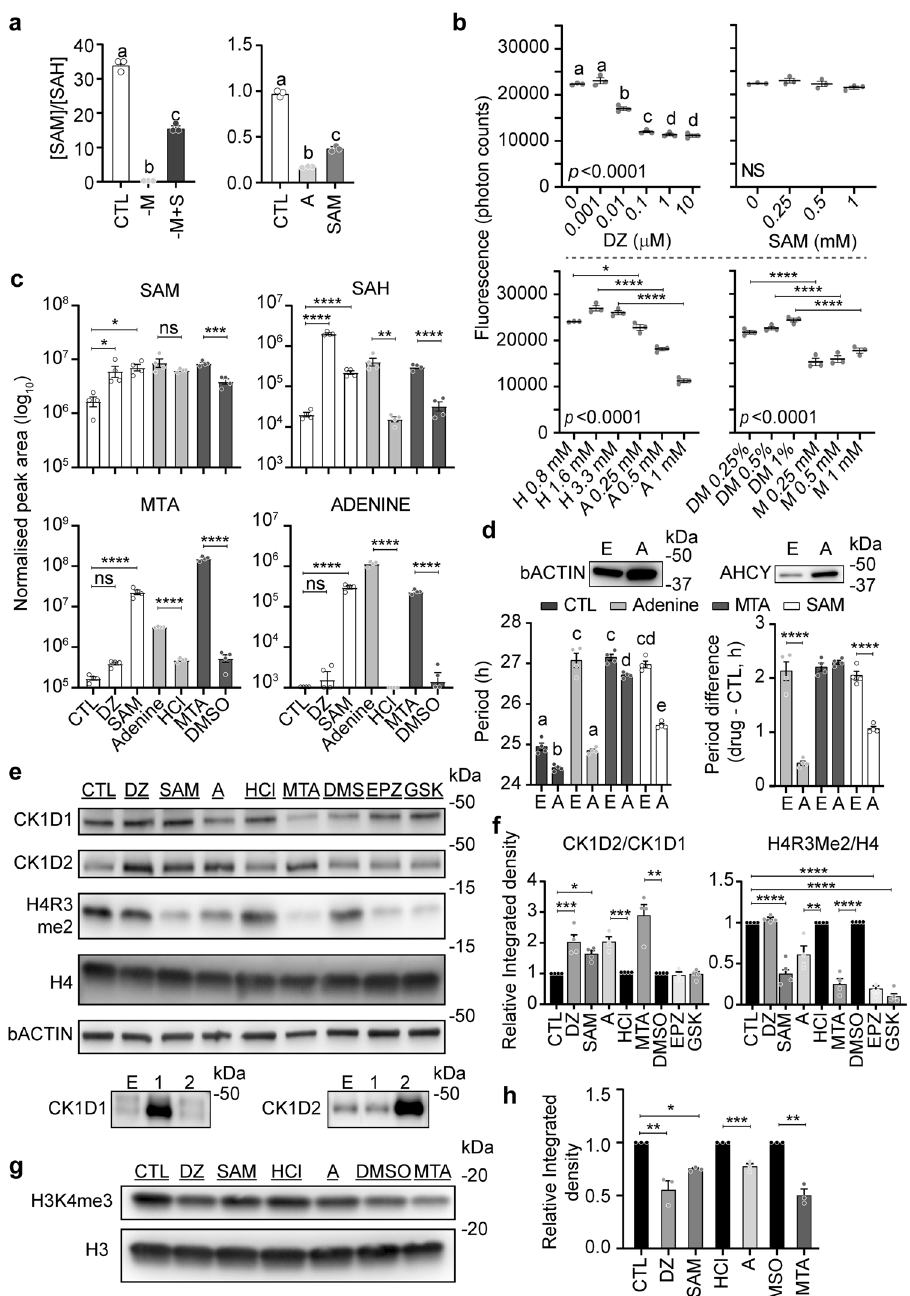
Fig. 3 Adenine and SAM disrupt the purine/pyrimidine ratio, but complementation by pyrimidines does not rescue the cells from period lengthening. a Heatmap representation of metabolites signi fi cantly regulated under 1 mM adenine (A) or 1 mM SAM (SAM). Red and blue represents higher and lower values, respectively (see legend on the right). Metabolites written in red are shown in the next panels. Note the parallel changes in SAH, purine, and pyrimidine nucleotides in adenine and SAM-treated cells. Global color scale based on mean + / − S.E.M. of n = 3 10 cm cell culture dishes. See also Supplementary Data 2. b – g Relative quanti fi cation of intracellular Met, SAM, SAH, cystathionine, MTA and adenine in cells treated with 1 mM adenine or 1 mM SAM. Data show mean + / − S.E.M. of n = 3 cell culture wells. h Cytosine (Cyto) or cytidine (Cyti) do not rescue PER2::LUC mouse embryonic fi broblasts from the period lengthening effects of adenine (Ade). Data show mean + / − S.E.M. of n = 4 cell culture wells. i In contrast to adenine, adenosine (Ado) does not signi fi cantly lengthens the circadian period. Data show mean + / − S.E.M. of n = 4 cell culture wells. All data shown as bar graphs analyzed by one-way ANOVA followed by Bonferroni multiple comparison test, a vs. b vs. c (labels at the top of each bar) at least p < 0.05. See also